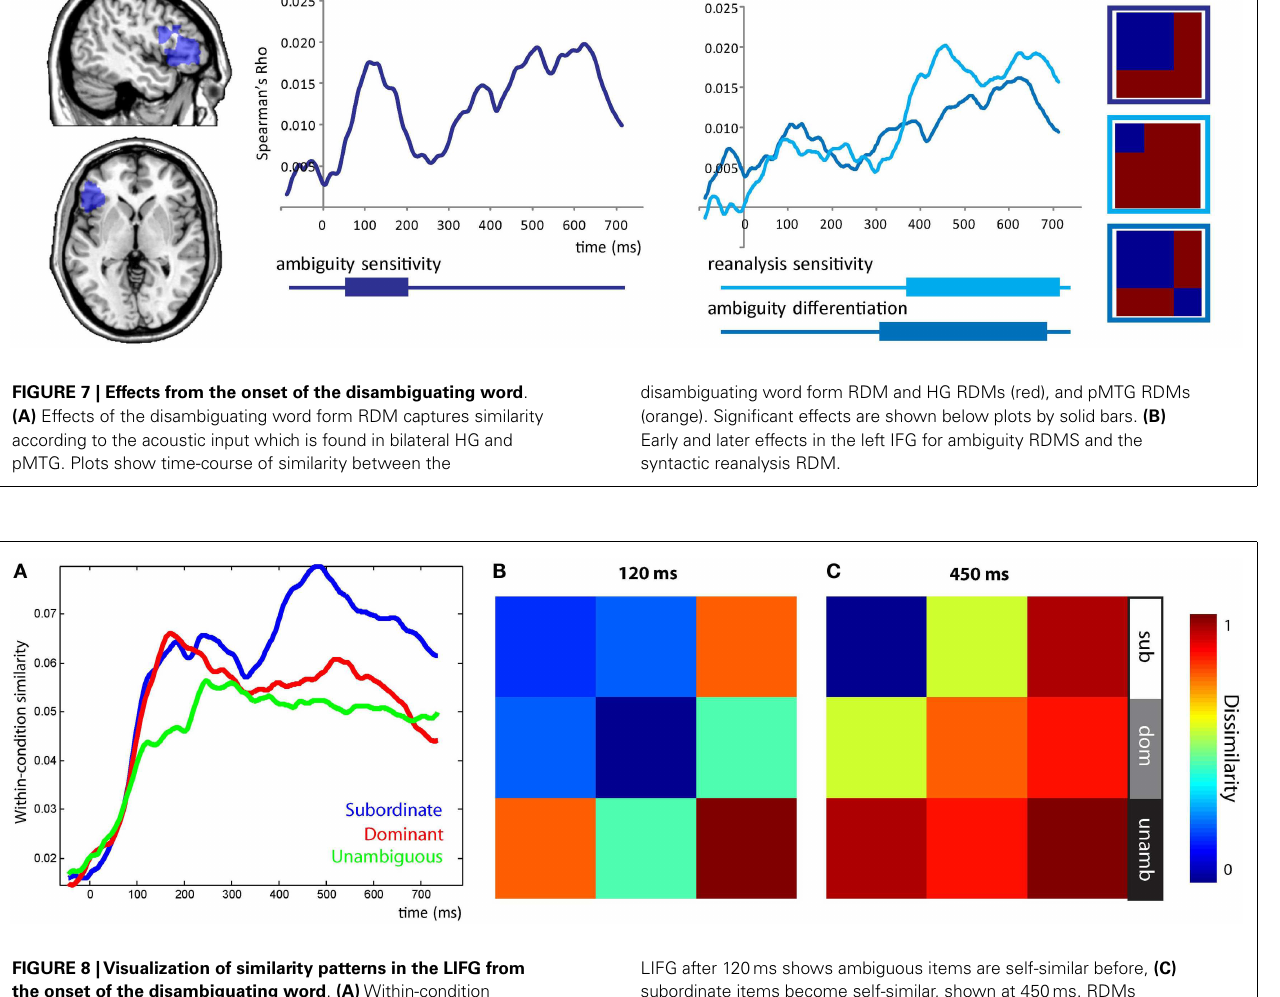
LIFG after 120ms shows ambiguous items are self-similar before, (C) subordinate items become self-similar, shown at 450ms. RDMs show the average similarity within each of the nine conditional